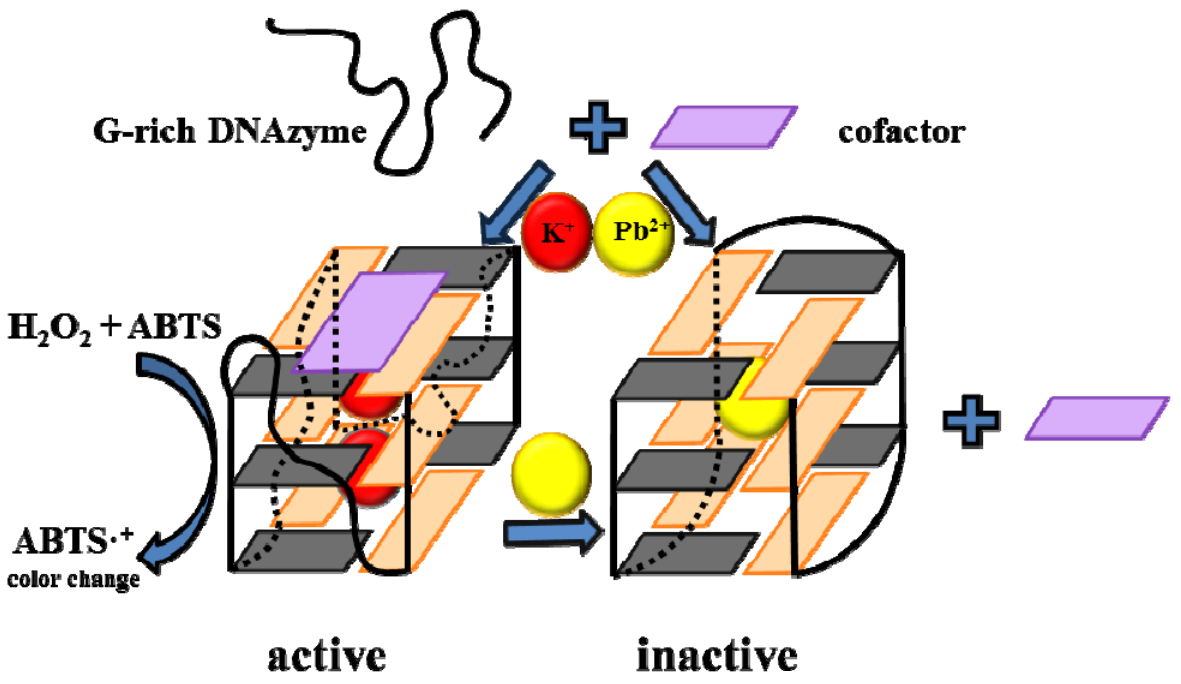
Figure 3. Construction of an INHIBIT logic gate based on the G-rich DNAzyme PW17, with K + and Pb 2+ as two inputs and absorbance as an output. Cofactor is hemin. In the quadruplex structures, anti and syn guanines are coloured cyan and orange, respectively. Adopted and modified according to Li et al.